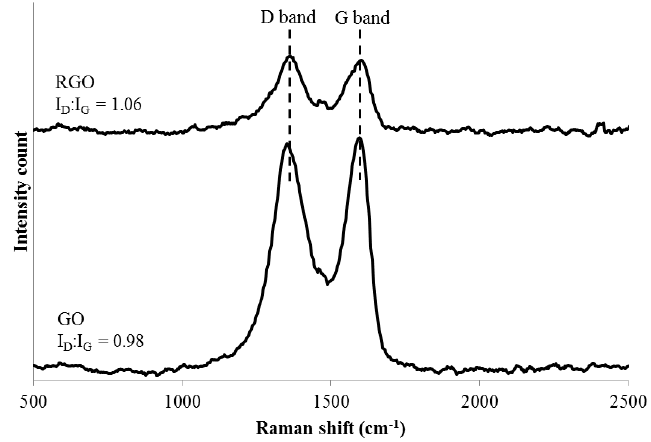
Figure 3. Raman spectra of GO and RGO.